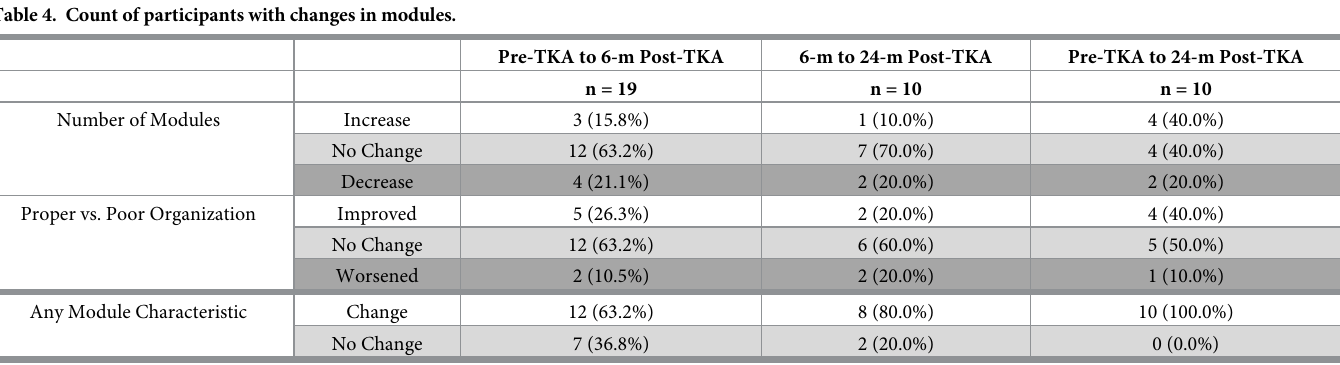
Table 4. Count of participants with changes in